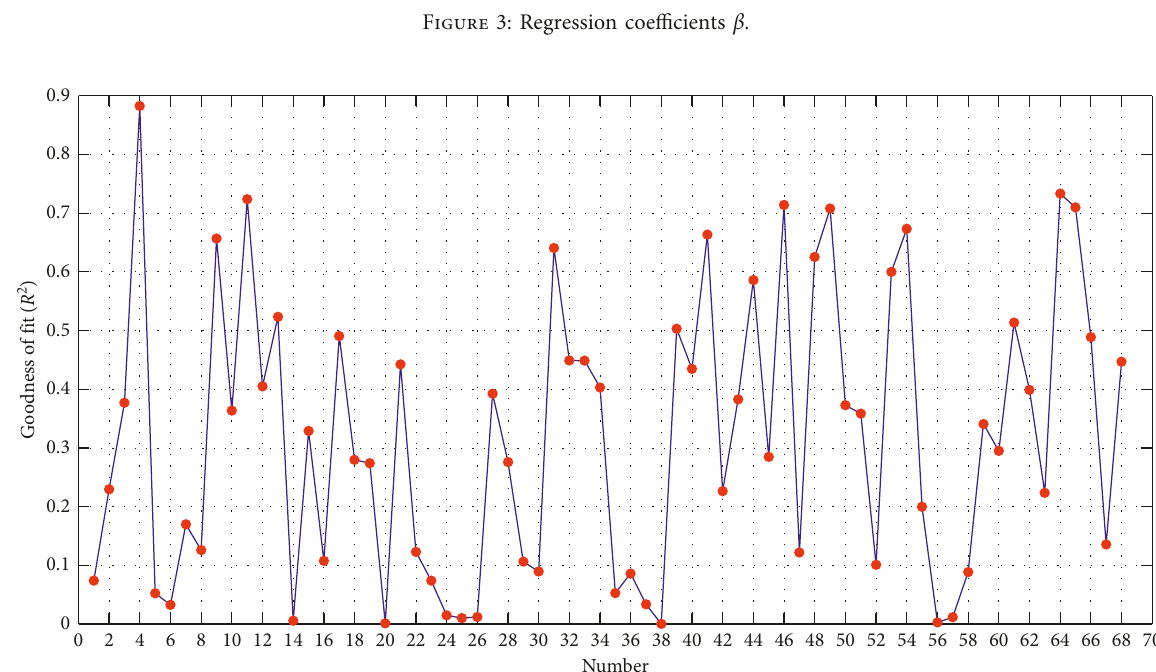
Figure 4: Goodness of fit R 2